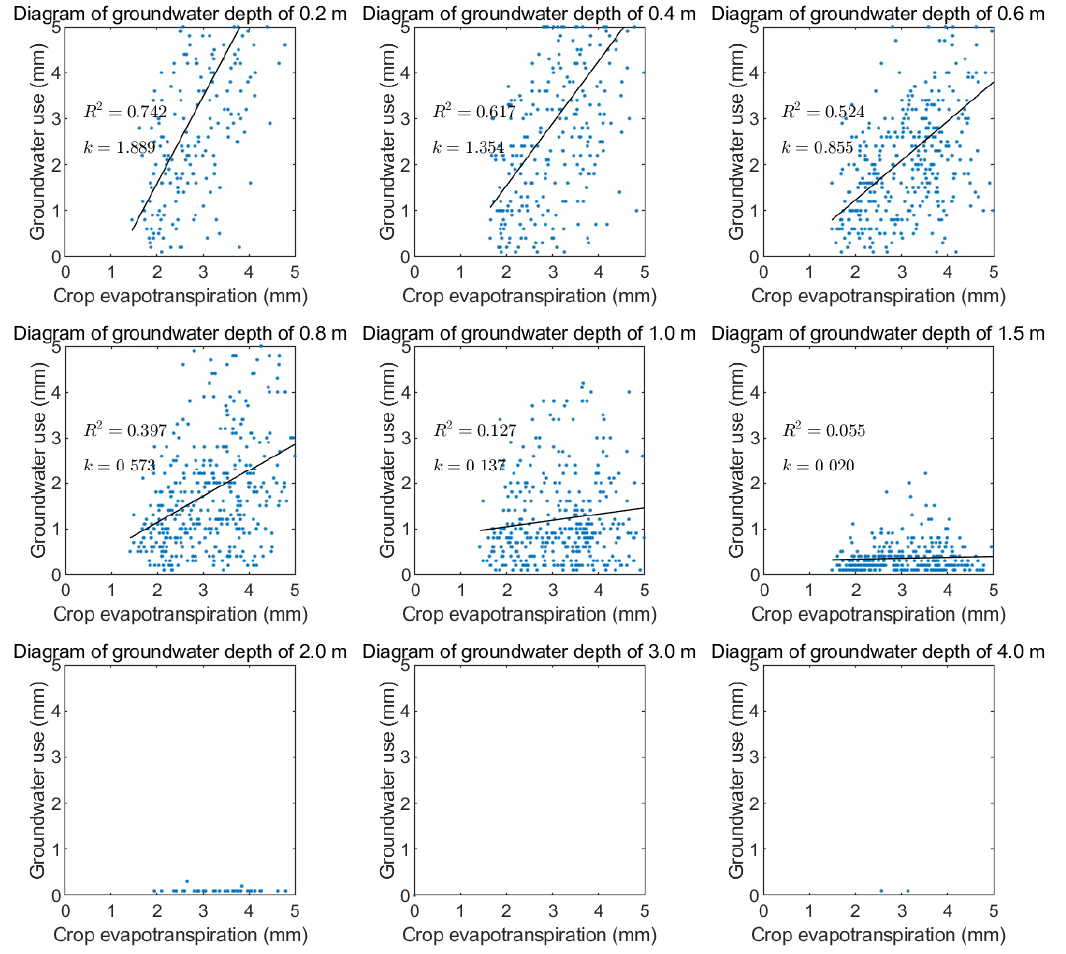
Table 2. Detailed growth period times for soybeans.